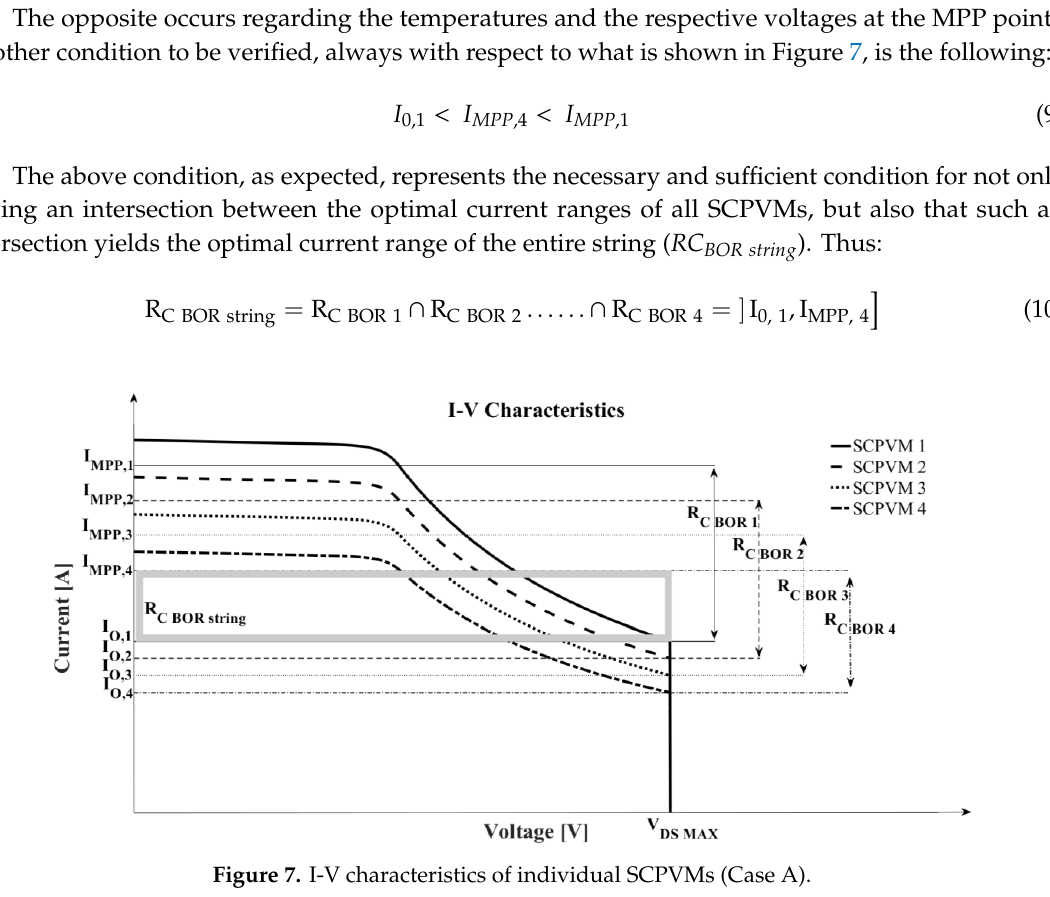
Figure 6. Constellation of all possible mismatching scenarios.